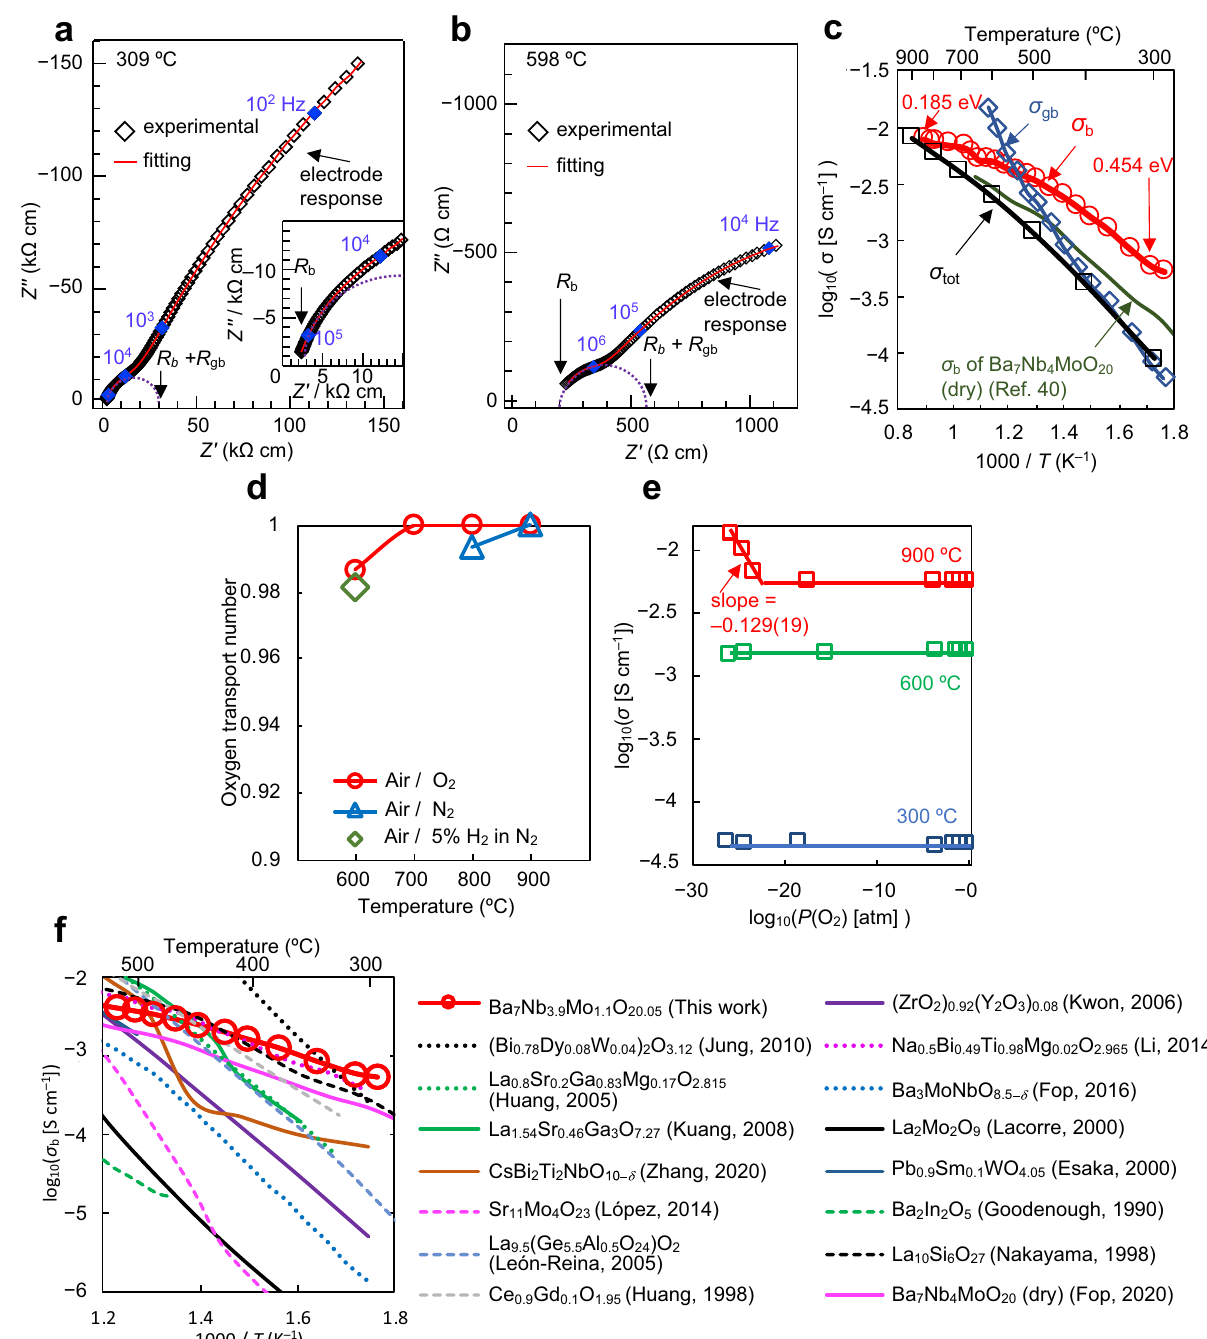
Fig. 1 High oxide-ion conductivity of Ba 7 Nb 3.9 Mo 1.1 O 20.05 . a , b Complex impedance plots of Ba 7 Nb 3.9 Mo 1.1 O 20.05 recorded in dry air at ( a ) 309 °C and ( b ) 598 °C. c Arrhenius plots of bulk conductivity σ b , grain-boundary conductivity σ gb and DC σ tot of Ba 7 Nb 3.9 Mo 1.1 O 20.05 in dry air. Activation energy for σ b of Ba 7 Nb 3.9 Mo 1.1 O 20.05 decreases with temperature from 0.454 to 0.185 eV as shown by the red numbers in panel c. Green line represents σ b of Ba 7 Nb 4 MoO 20 reported by Fop et al. 40 . d Oxygen transport number of Ba 7 Nb 3.9 Mo 1.1 O 20.05 . e Oxygen partial pressure P (O 2 ) dependence of σ tot of Ba 7 Nb 3.9 Mo 1.1 O 20.05 . f Comparison of bulk conductivities of Ba 7 Nb 3.9 Mo 1.1 O 20.05 and other oxide-ion oxide-ion conductor. No change was observed in the X-ray comparable to those of the best oxide-ion conductors (Fig. 1f). It powder diffraction patterns before and after the oxygen con- should be noted that the σ b of Ba 7 Nb 3.9 Mo 1.1 O 20.05 was higher than the best oxide-ion conductors at temperatures of around centration cell measurements (Supplementary Fig. 15), which 300 °C, due to the low activation energy of Ba 7 Nb 3.9 Mo 1.1 O 20.05 demonstrates the high phase stability of Ba 7 Nb 3.9 Mo 1.1 O 20.05 at (0.185-0.454 eV as shown in Fig. 1c). These results indicate the high temperatures and in the wide P (O 2 ) region between P (O 2 ) = 1.2 × 10 − 27 and 1 atm. The σ b of Ba 7 Nb 3.9 Mo 1.1 O 20.05 was found high potential of the hexagonal perovskite related oxide to be higher than those of Ba 7 Nb 4 MoO 20 40 (Fig. 1c) and YSZ, and Ba 7 Nb 3.9 Mo 1.1 O 20.05 as a superior oxide-ion conductor.